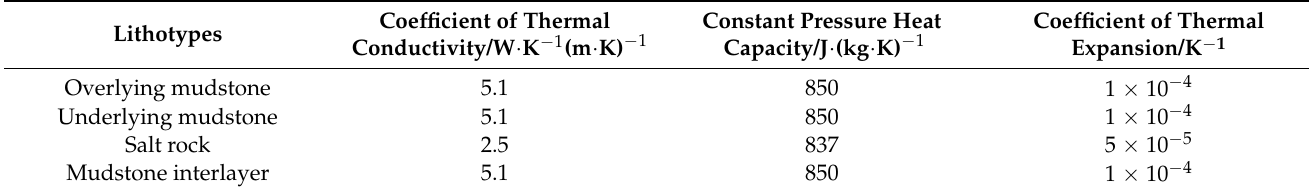
Table 2. Rock thermal